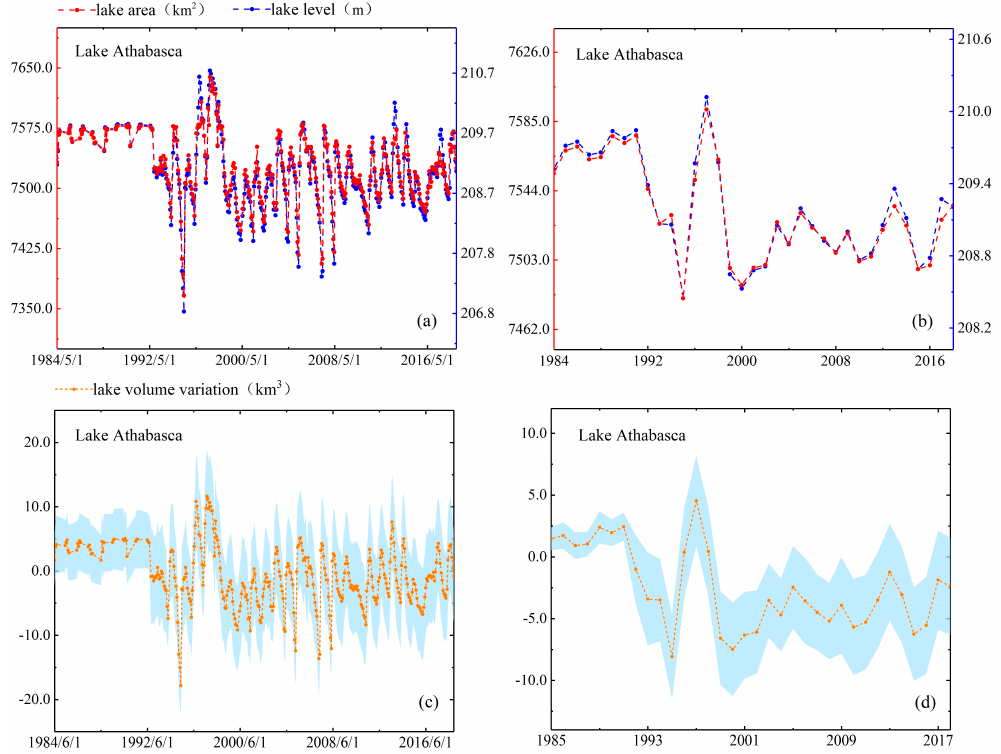
Figure 4. Lake area, level and volume variations in monthly ( a , c ) and annual ( b , d ) timescales for Lake Athabasca.